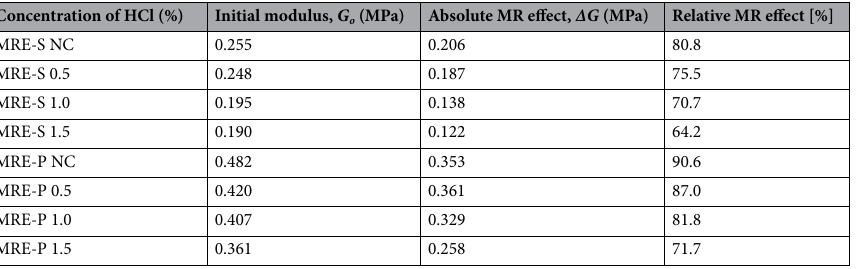
Table 4. Absolute and relative MR effect for all